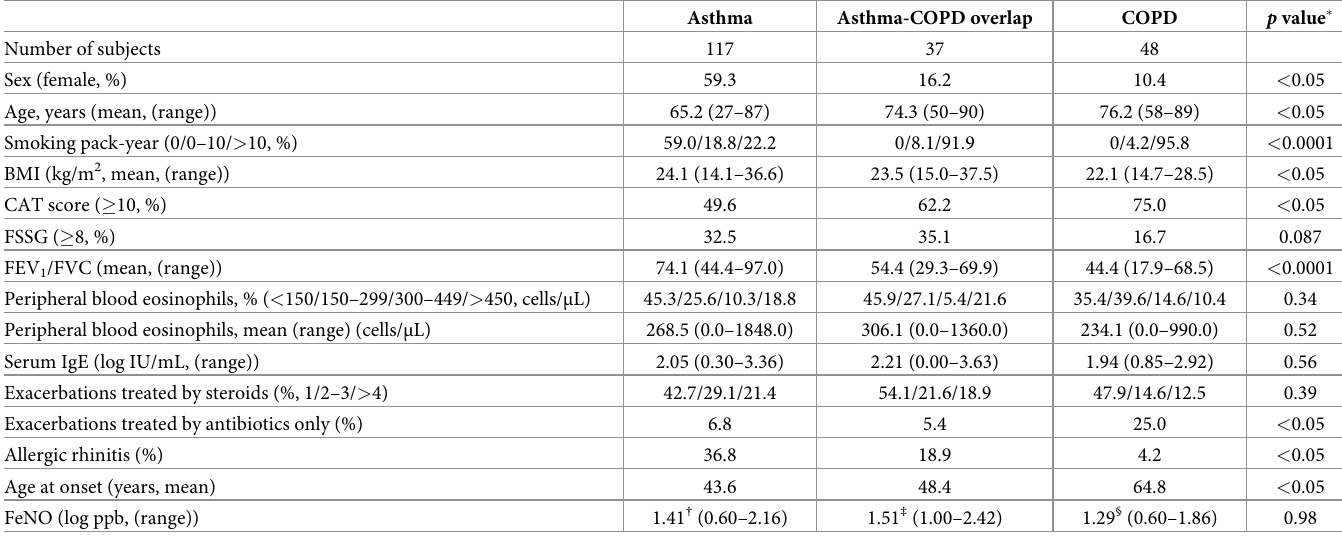
Table 1. Characteristics of the study